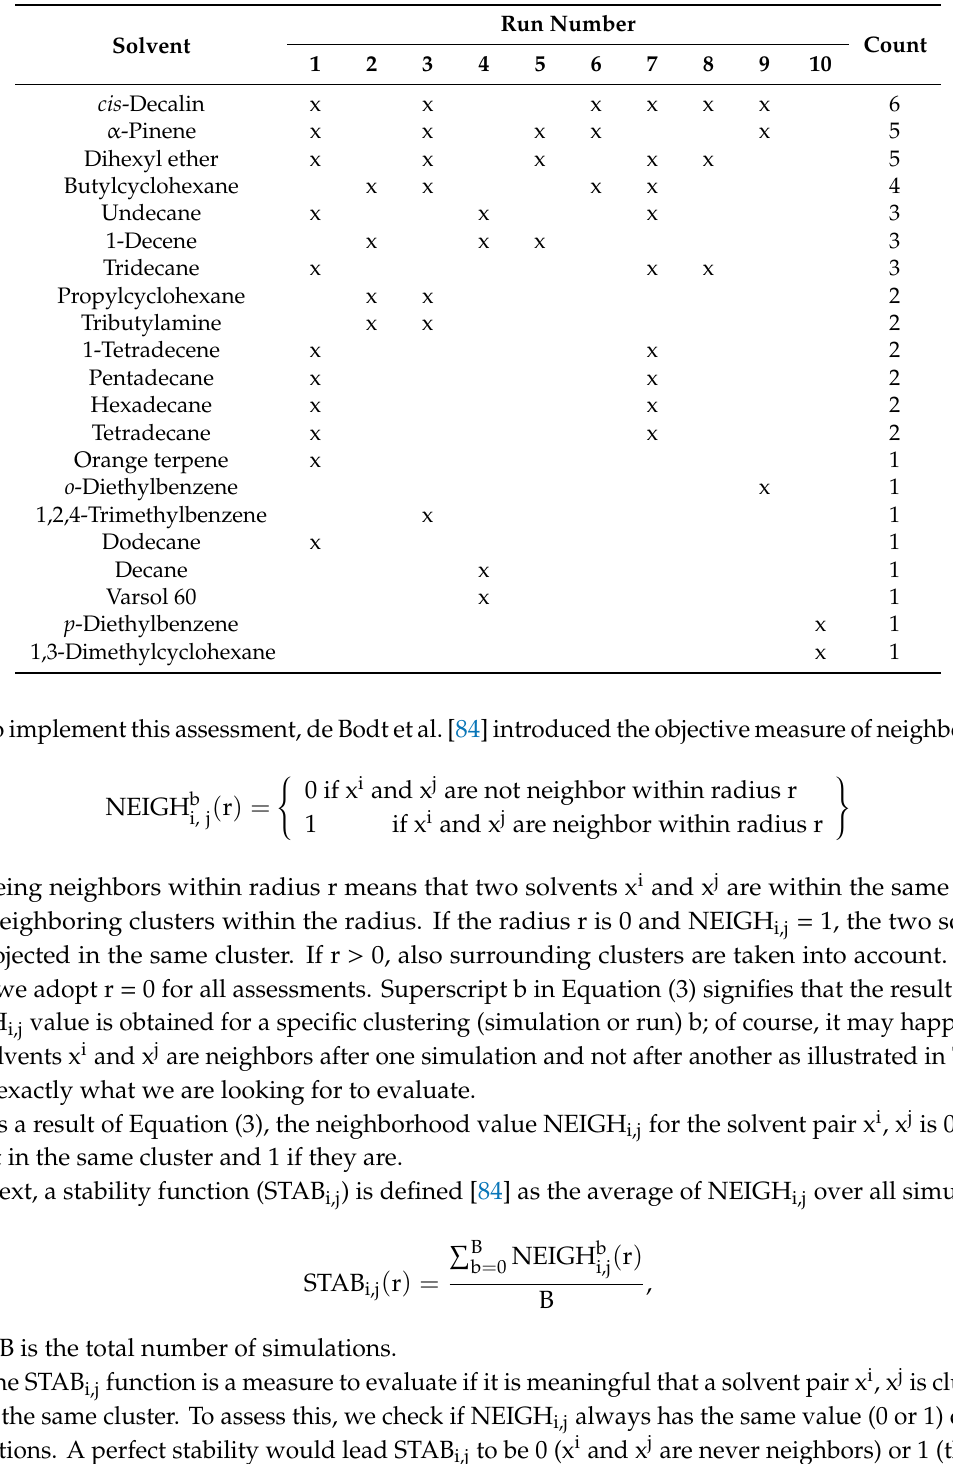
Table 7. Contents of “limonene cluster” for first 10